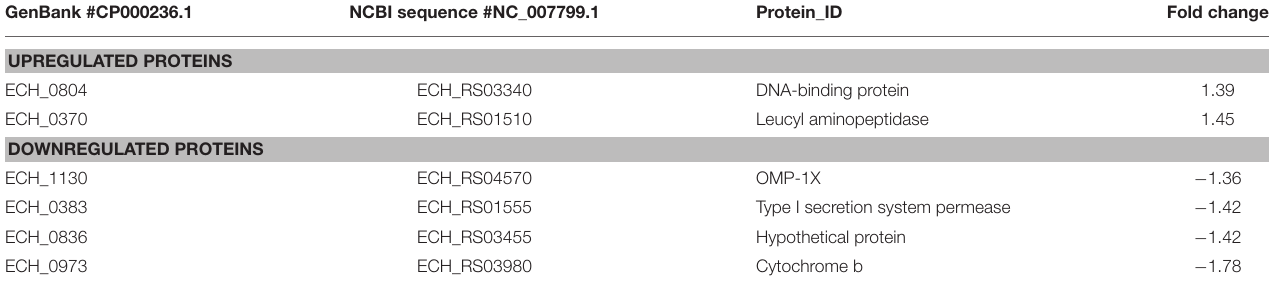
TABLE 3 | Proteins differentially expressed in mutant ECH_0660.